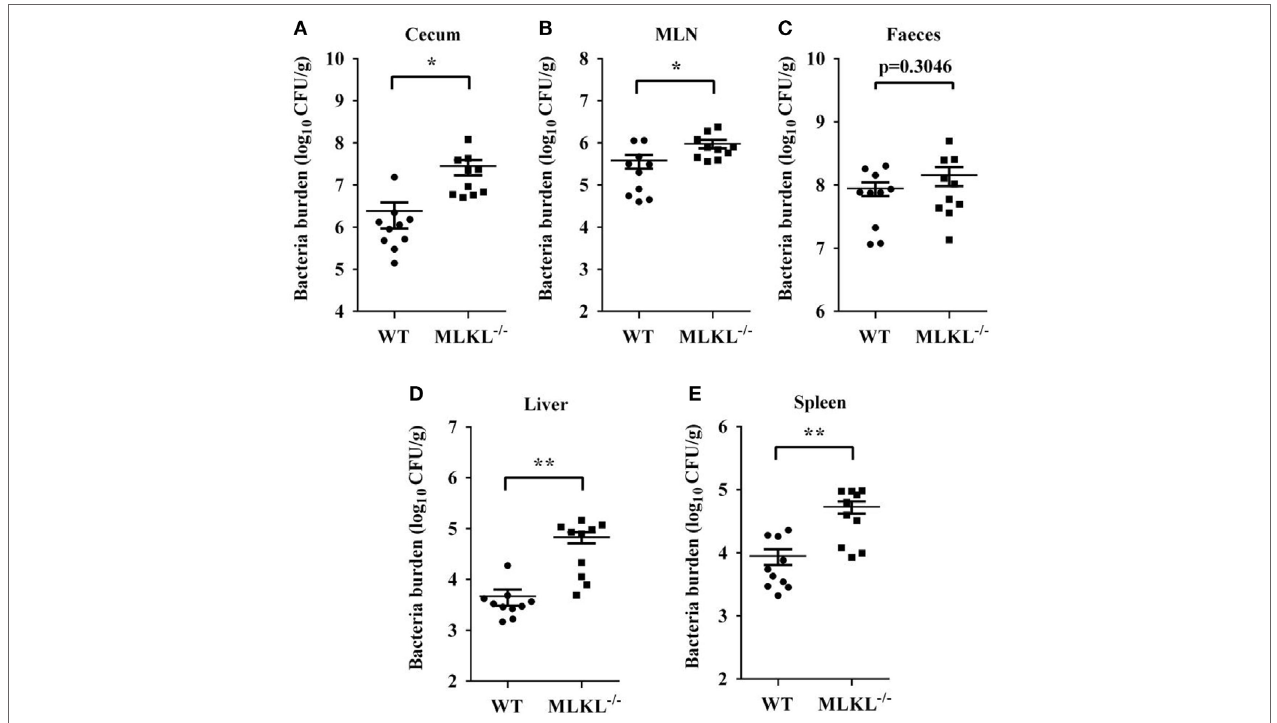
FigUre 3 | MLKL restricts Salmonella invasion and dissemination. Streptomycin-pretreated WT and MLKL − / − mice were orally infected with Salmonella (5 × 10 7 CFU, n = 10 each group) for 48 h. Bacterial load in the cecum (a) , mesenteric lymph node (MLN) (B) , feces (c) , liver (D) , and spleen (e) were detected. All data are shown as mean ± SEM. Student’s t -test was performed. Statistical significance is indicated by * p < 0.05, ** p <